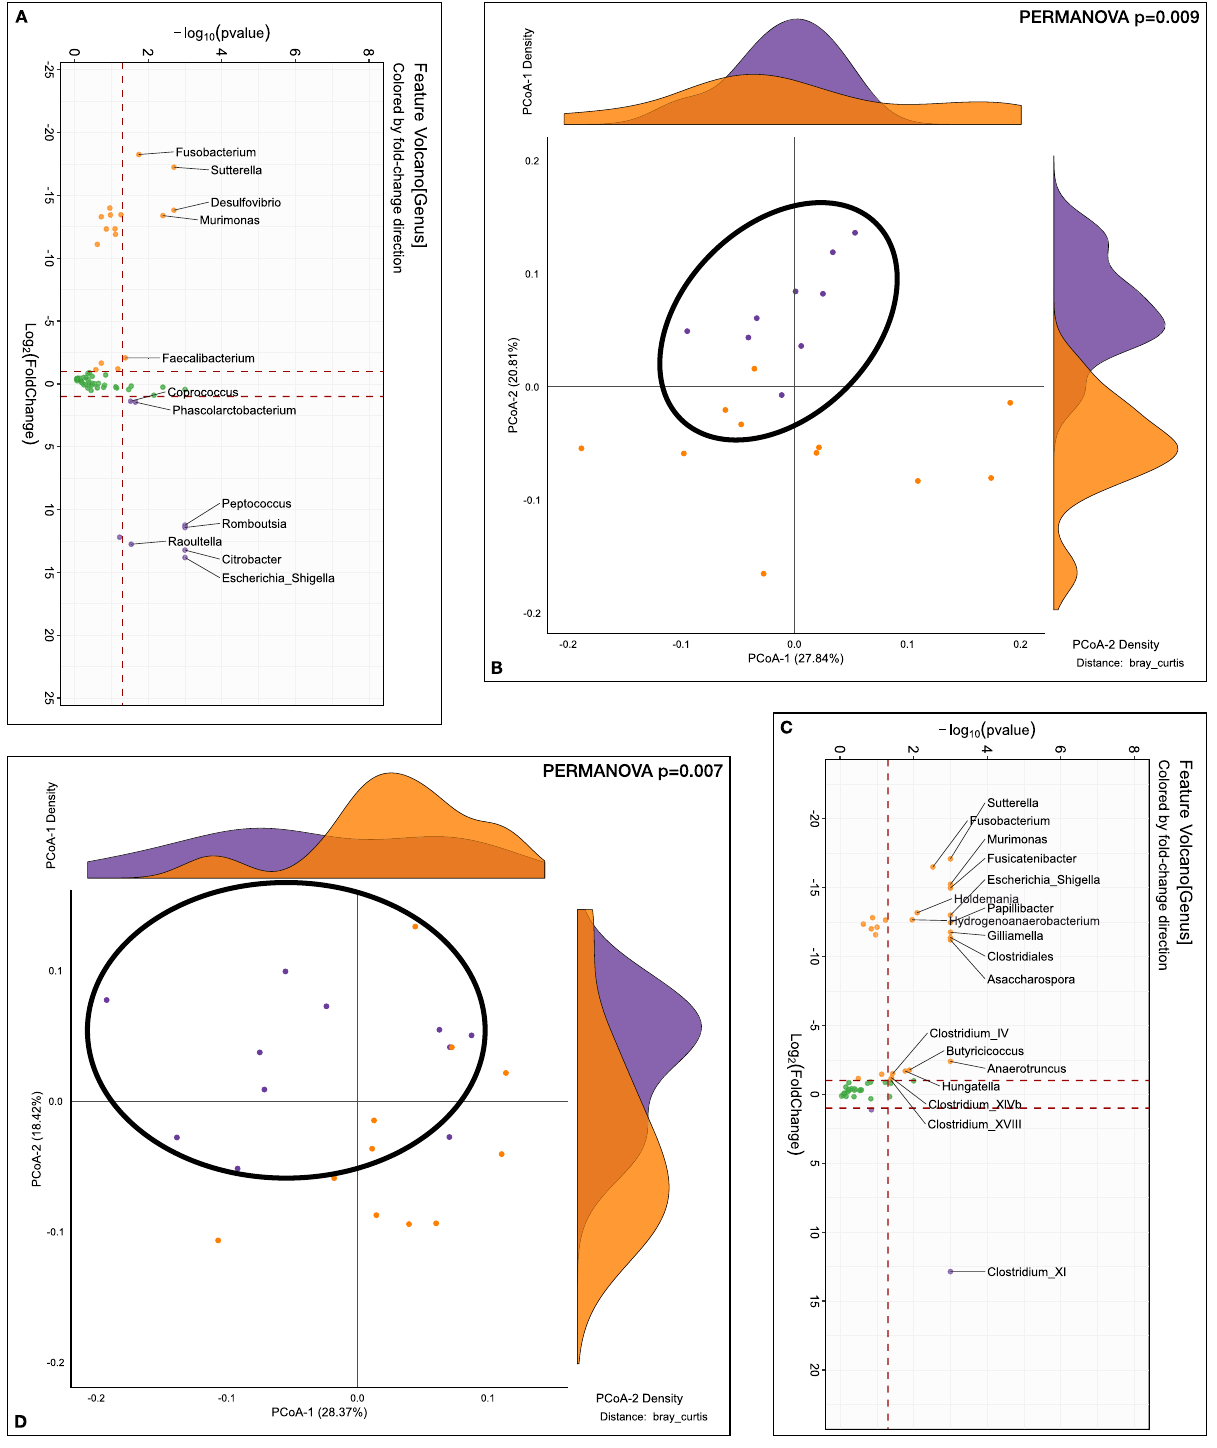
Fig. 5 | Stool microbiota analyses before and after alcohol preference experi- ment. A , B Comparison between mouse recipients ’ fecal samples at genus level before alcohol exposuret, Purple: Pre-FMT, Orange: Post-FMT. A log2fold changes Volcanoplottedagainstthelog10 p valuedifferencesbetweenthepre-FMT(purple) and post-FMT (orange). B β -diversity analysis using Bray-Curtis distance on PCoA showing signi fi cant separation between groups (PERMANOVA, p =0.009).